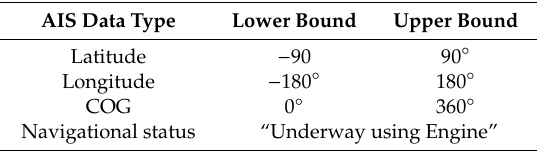
Table 5. Bound values for data